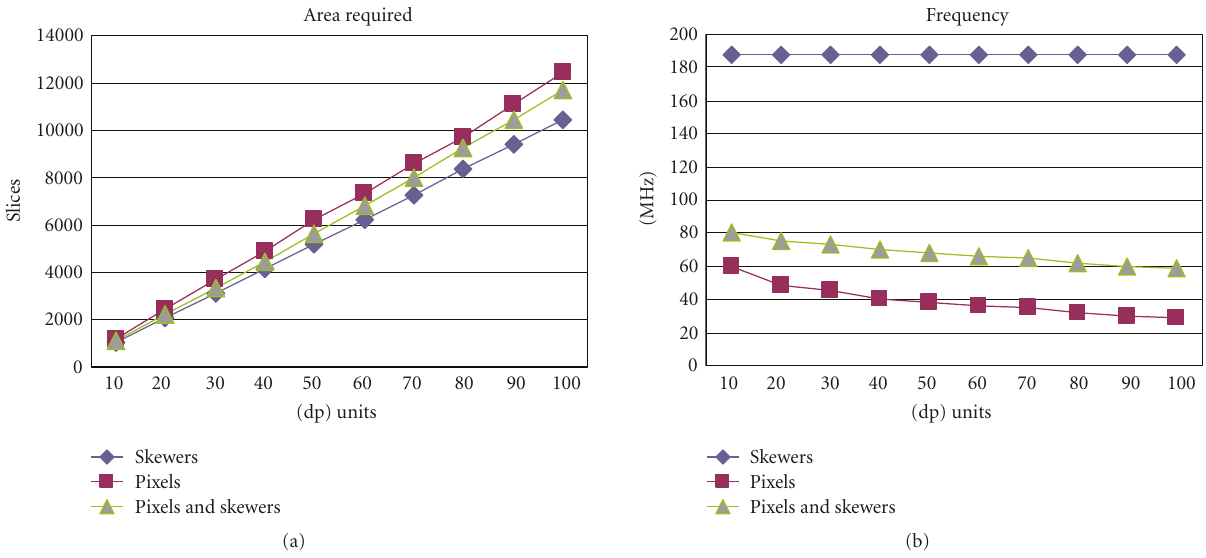
Figure 5: (a) Area required (in slices) by dot-processing units in di ff erent parallel implementation strategies of the PPI. (b) Clock cycle required (in MHz) by dot-processing units in di ff erent parallel implementation strategies of the PPI.